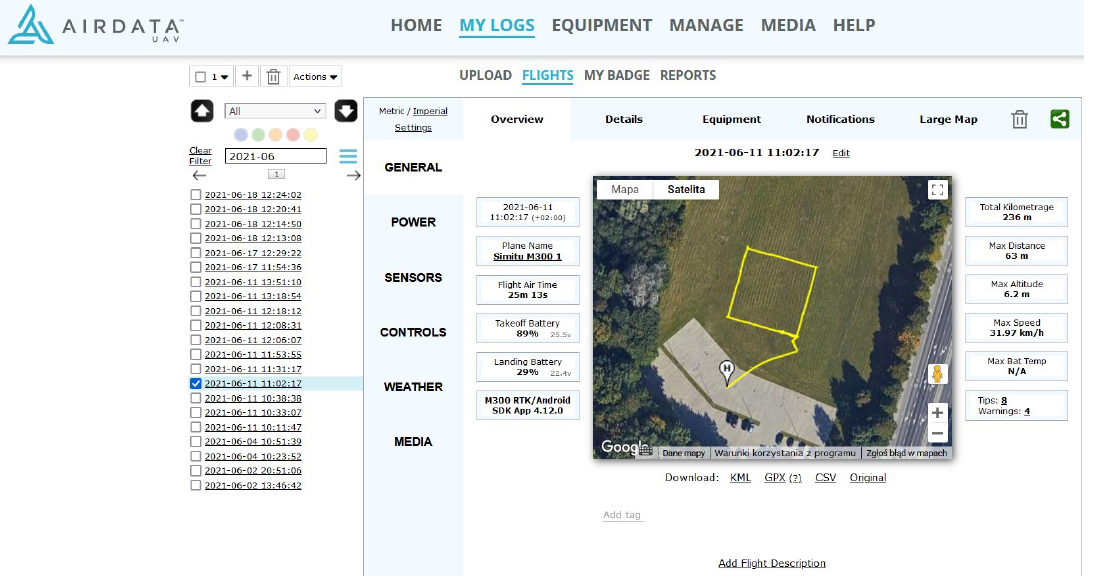
Table 1. Statistics for measured coordinates (altitude H = 1. 5 m ).